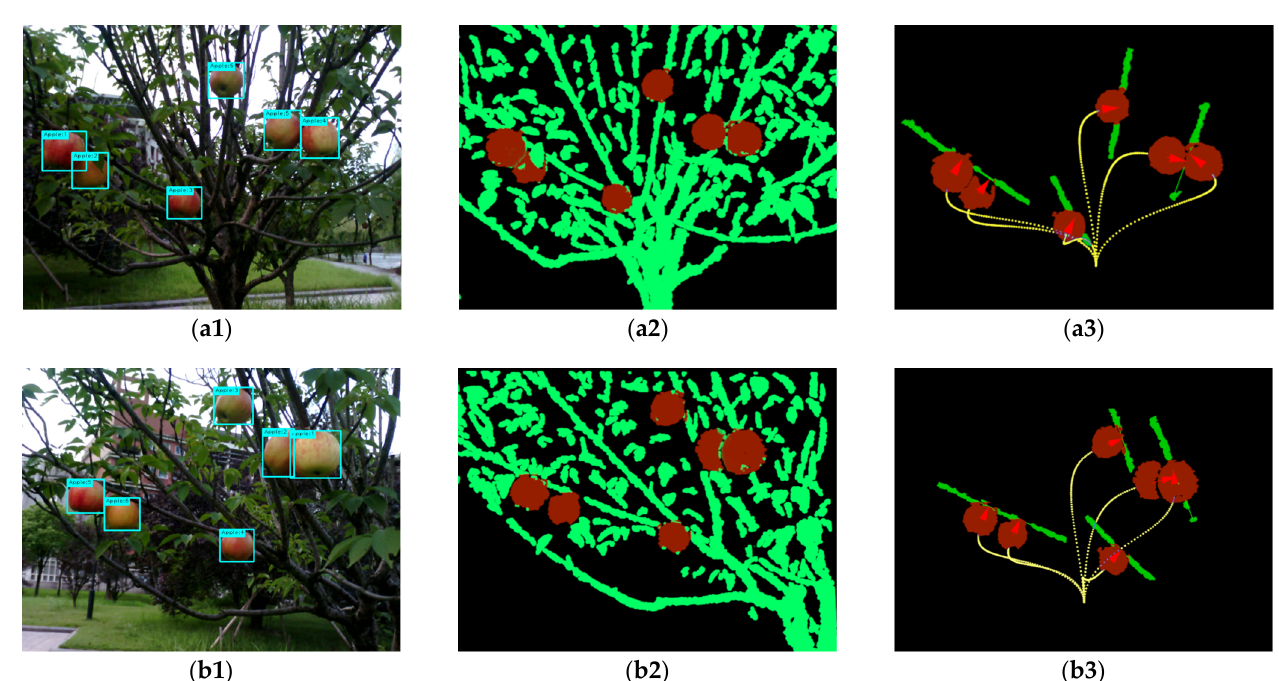
Figure 16. Fruit and environment modeling on orchard RGB-D images. ( a1 , b1 ) are fruit identification through RGB images; ( a2 , b2 ) are the extracted fruit point clouds; ( a3 , b3 ) are graphs for calculating picking directions. The apple and grasping direction are indicated by red dots and red arrows. Branches and leaves are represented by green dots. The yellow curve is the picking path of the end effector.